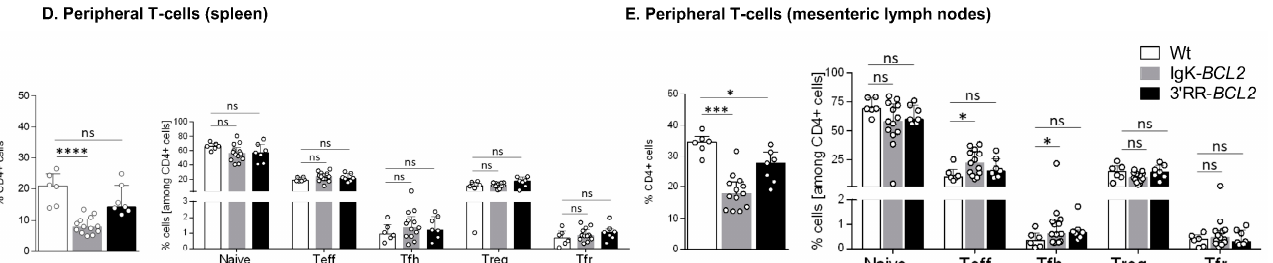
Figure 2. B cell development and lymphoid compartments in resting mice Flow cytometry data showing the impact of BCL2 deregulation alone, in both mouse models compared to WT mice in non-immunized conditions, on the different B cell compartments, in bone marrow ( A ), spleen ( B ) and mesenteric lymph nodes ( C ), as well as on the T cell compartment in spleen ( D ) and mesenteric lymph nodes ( E ). Percentages of the different cell compartments are presented as medians with interquartile range and the statistical significance was determined by the Mann–Whitney U test. Ratios